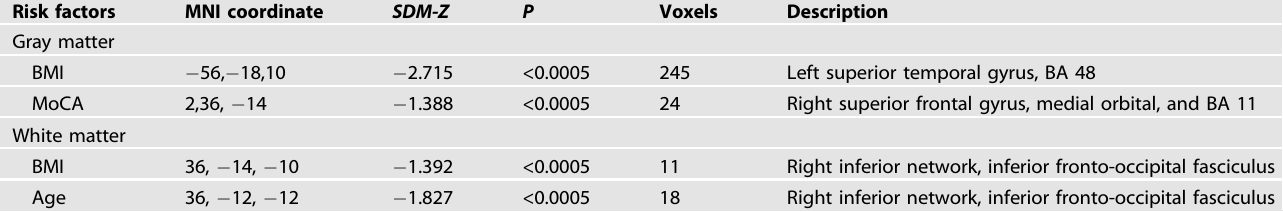
Table 3. The relationship between Age, BMI, MoCA and decreased GM/WM in patients with T2DM-CD. Risk factors